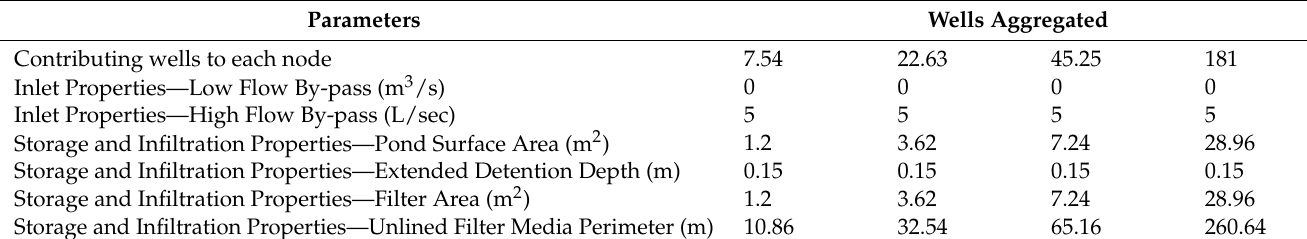
Table 5. Adopted values for different parameters due to aggregation of wells in combined nodes.